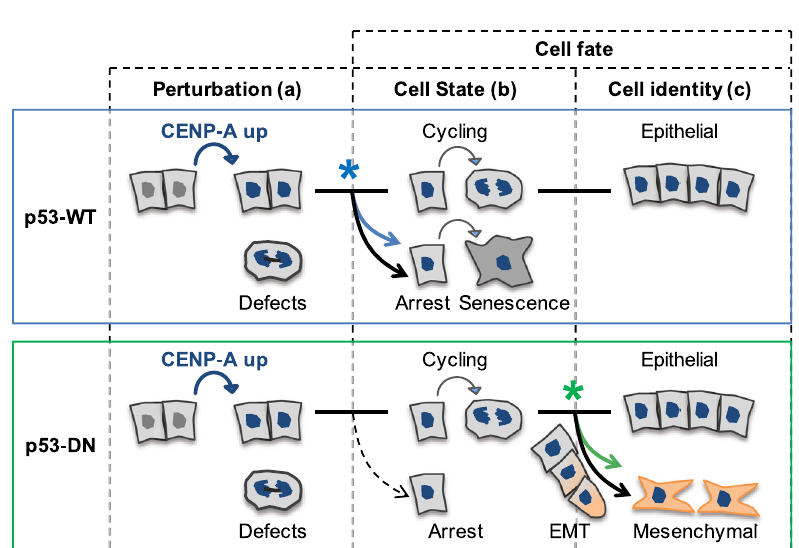
Fig. 6 CENP-A overexpression promotes epithelial – mesenchymal transition in p53-defective cells. a Cell fate trajectories inferred by RNA velocity analysis of scRNA-seq samples illustrated in Fig. 5a. RNA velocities estimated by dynamical modeling across all samples are depicted in the left panel by a streamline plot (black arrows) showing the main directional fl ow across cells (gene-averaged velocity vector fi eld in UMAP embedding from Fig. 5). Each cell is colored by the estimated latent time from initial (blue, start) to terminal states (red, end). Left: RNA velocities calculated across all conditions. Right: RNA velocities calculated separately for each condition by stochastic modeling in individual samples. b Principal component analysis (PCA) of scRNA-seq experiments. All conditions merged. Each dot represents a single cell on the fi rst (PC1) and third (PC3) principal components, colored by expression of epithelial – mesenchymal transition genes (EMT; Hallmark gene set, MSigDB v6.2). Cell-to-cell variability along the third principal component can be explained by differences in expression of EMT genes. c Classi fi cation of epithelial and mesenchymal subpopulations based on Leiden clustering after correcting for cell cycle effects. Left: the color gradient shows, for each cell, the relative expression trend of genes involved in EMT (EMT; Hallmark gene set, MSigDB v6.2) in UMAP space. See also Supplementary Fig. 5D for additional EMT signatures. Right: classi fi cation of cells as mesenchymal (EMT high cluster, orange) and epithelial (EMT low clusters, gray), divided as either cycling (dark) or non-cycling (pale), as determined in Fig. 5. d Stacked bar plot showing the percentage of cells within the mesenchymal cluster per experimental condition. e Assessment of EMT by immuno fl uorescence after 34 days with ( ++ ) or without ( − ) continuous CENP-A overexpression (10 ng/ml Dox). Left: representative max intensity projections: DAPI (cyan), E-cadherin (yellow, epithelial marker), and vimentin (magenta, mesenchymal marker). Scale bars = 40 µ m, Zoom = 20 µ m. Right: quanti fi cation of the frequency of cells with high vimentin surrounding the nucleus and low/absent E-cadherin on the cell membrane for each condition. Plot shows mean and 95% con fi dence interval from three biological replicates (gray circles). N = > 1000 nuclei per condition per replicate. Similar results were obtained in a second